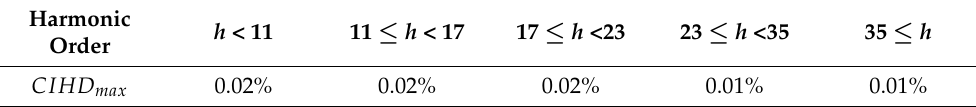
Table 1. IEEE Std. 519 current individual distortions limits for systems rated 33